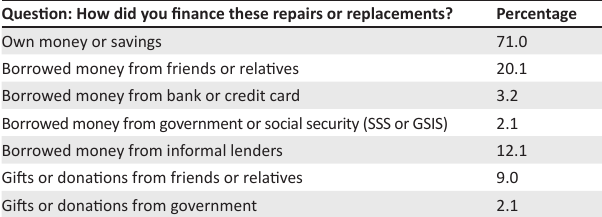
TABLE 7: Financing repairs or